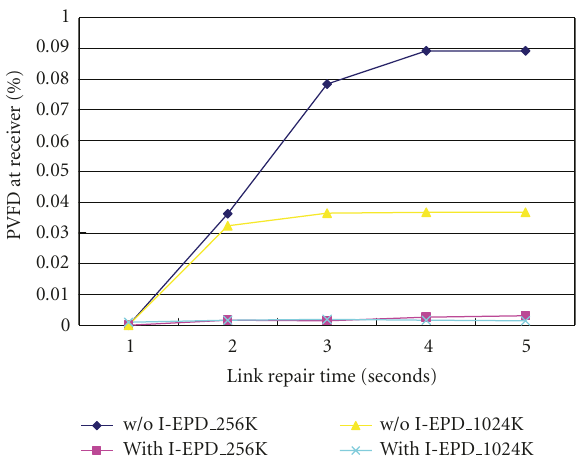
Figure 13: PVFD R versus link repair